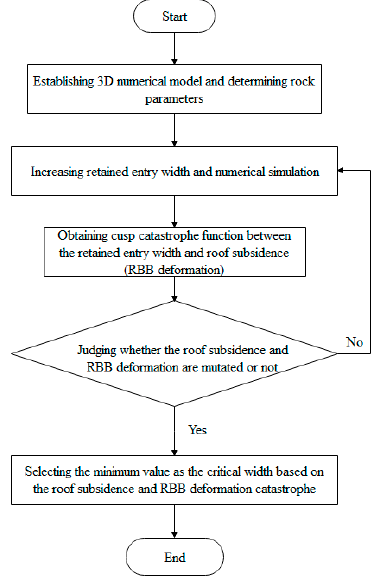
Figure 5. Calculation flow chart.